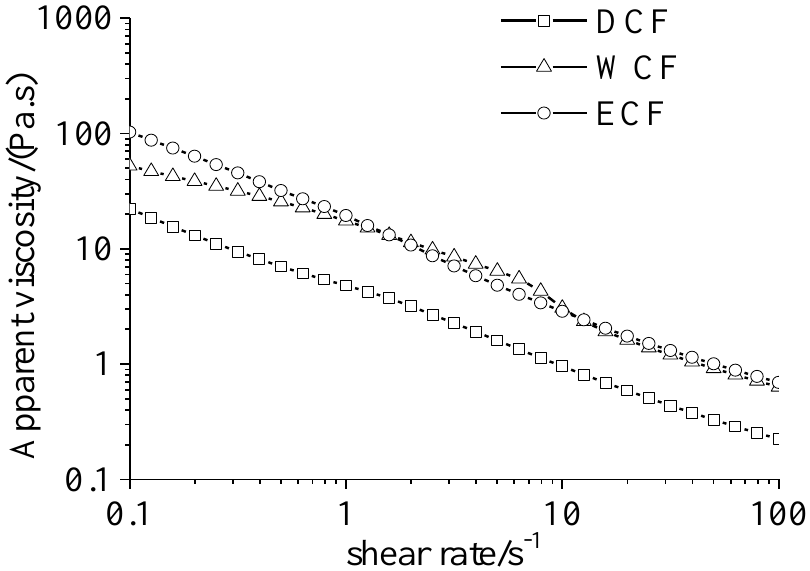
Figure 3. Behavior of the apparent viscosity of corn flour. DCF: dry-milling corn flour; WCF: wet-milling corn flour; ECF: enzymatic wet-milling corn flour. Table 4. The Hereschel-Bulkey model parameters of corn flour paste.